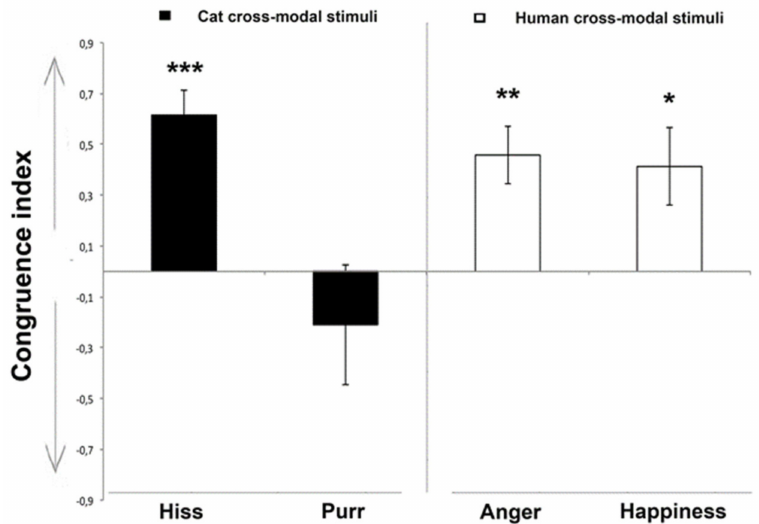
Figure 3. Congruence index for the cross-modal matching of each cat during the experiment: a score of 1.0 represents an exclusive look at the congruent emotional face and − 1.0 represents an exclusive look at the incongruent face (group means with SEM are shown). Asterisks indicate significant biases. * p < 0.05; ** p < 0.01; *** p < 0.001 (One-Sample t